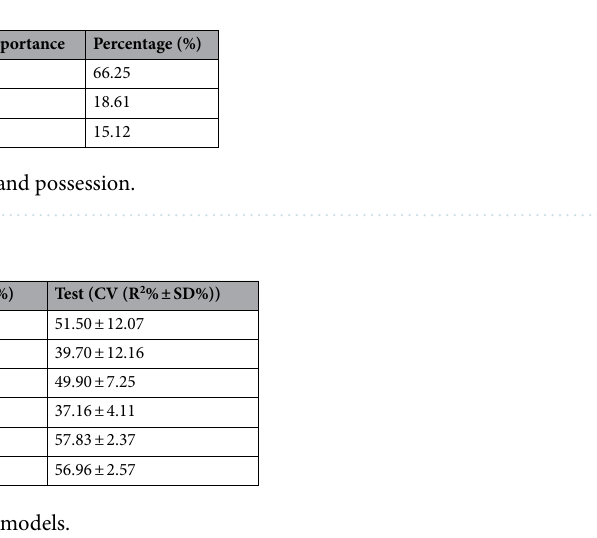
Table 7. Cross validation results for all